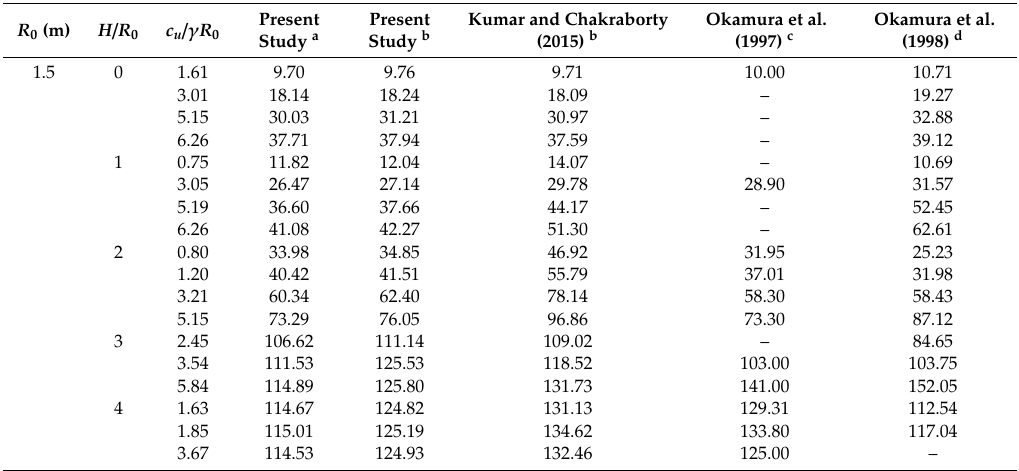
Table 4. Comparison of p u / ( γ R 0 ) for a rough circular foundation on sand overlying clay ( ϕ = 40 ◦ ). R 0 (m) H / R 0